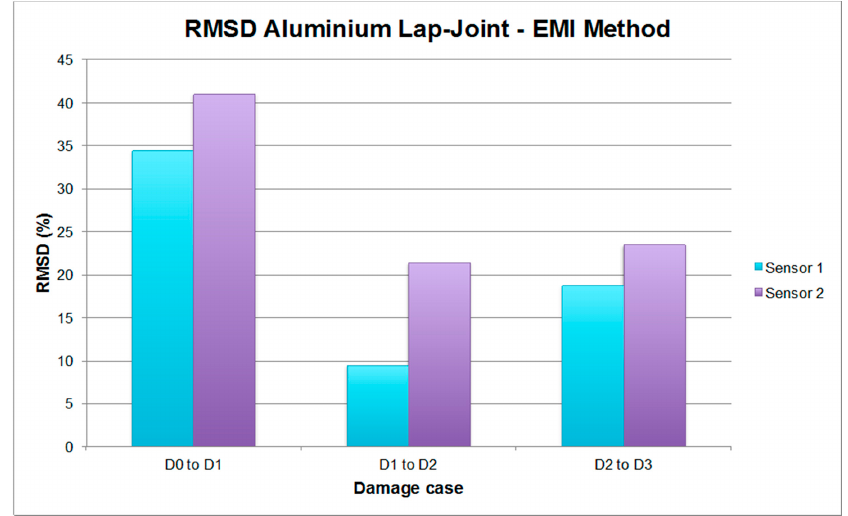
9 Figure 9. RMDS values for the bolt-jointed aluminium beam corresponding to the EMI